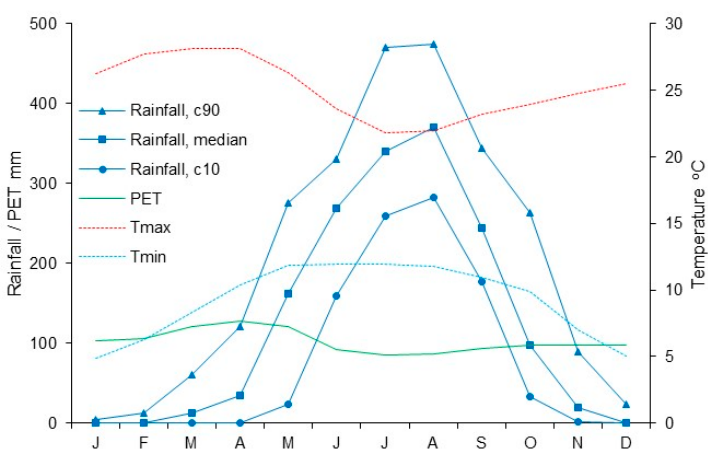
Figure 2. Monthly median, 10th and 90th percentile rainfall, mean potential evapotranspiration, and maximum and minimum temperatures as measured (since 1988) by the National Meteorology Agency (NMA) at Dangila weather station.